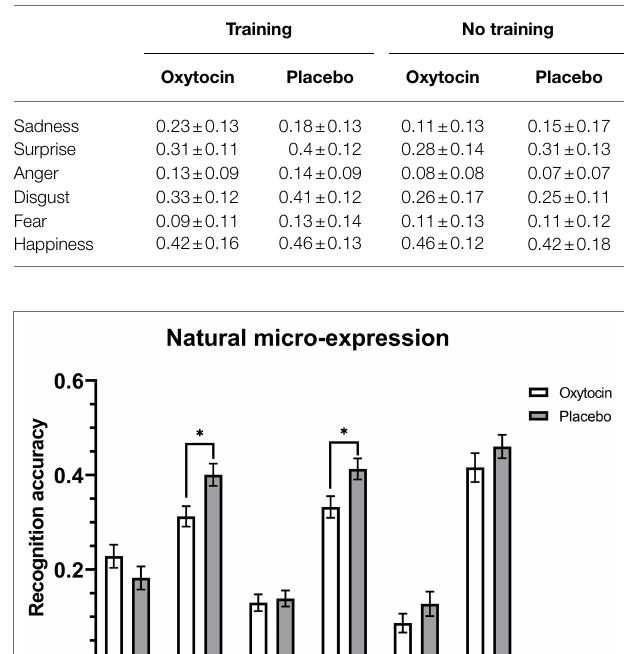
TABLE 6 | The recognition accuracy of natural micro-expression recognition task in Study 3 ( M ± SD